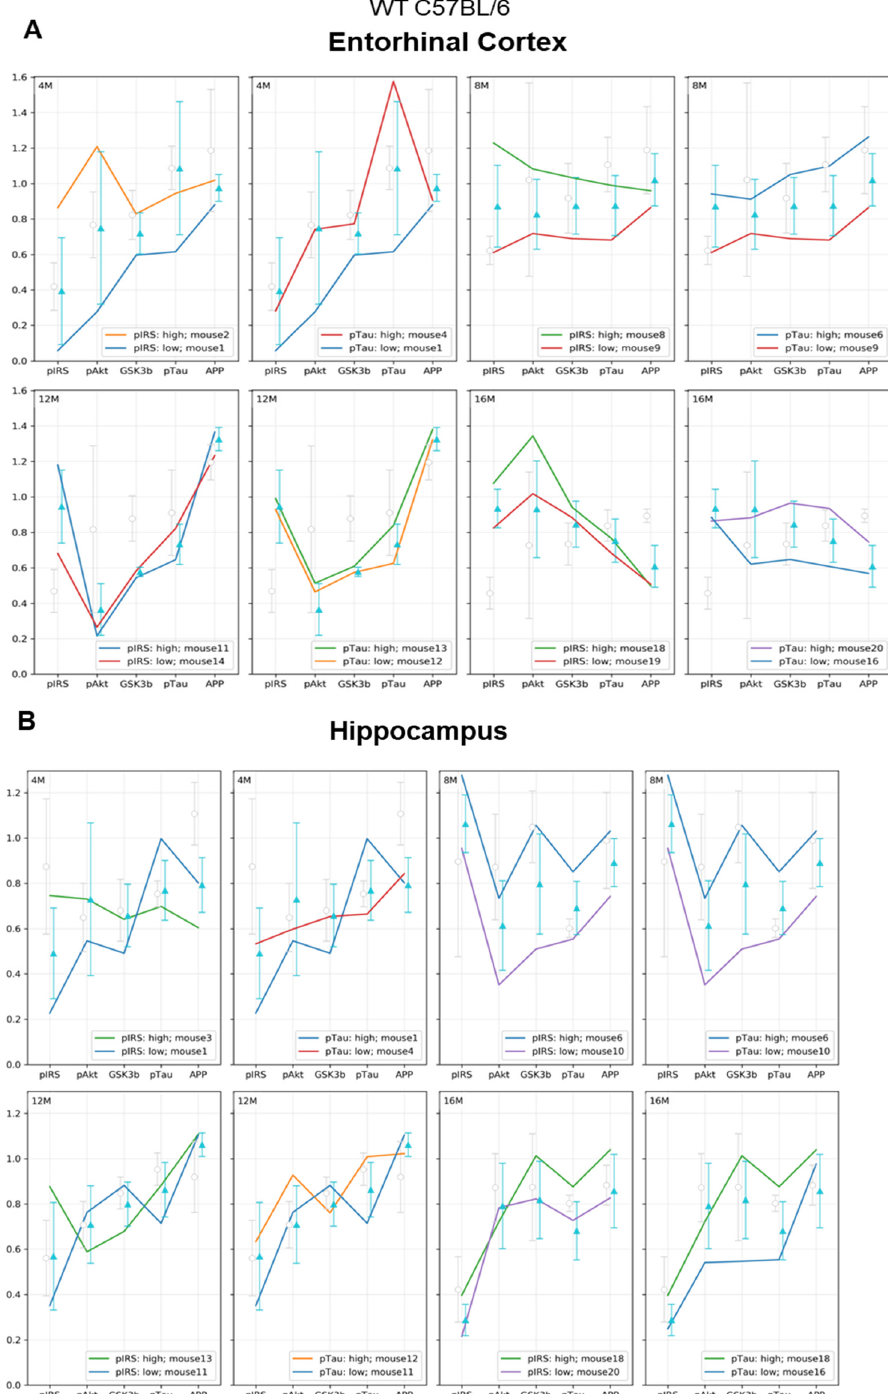
Figure 5. ( A ) Entorhinal cortex and ( B ) hippocampus. Graphs show a linear representation of the relationship of p-Akt(Ser473), p-GSK-3 β (Ser9), and APP levels to the minimum and maximum values of p-IRS-1(Ser616) and p-Tau(Thr231). Each colored line represents the results for individuals fed the WD at each age group (4M WD, 8M WD, 12M WD, and 16M WD). The standard deviation ranges for the groups fed the Western diet (WD) are shown in light blue as reference ranges. The standard deviation ranges for the groups fed the standard diet (CTR) are indicated in light gray color as reference ranges. (Analysis of extreme values for each individual in all experimental groups is attached in Supplementary Materials: Figure S1).